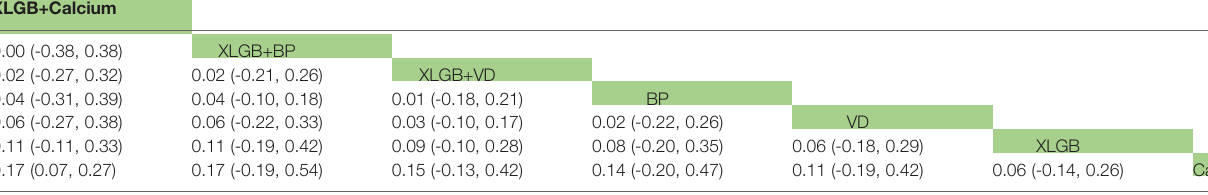
TABLE 8 | Network meta-analysis of femoral neck BMD.